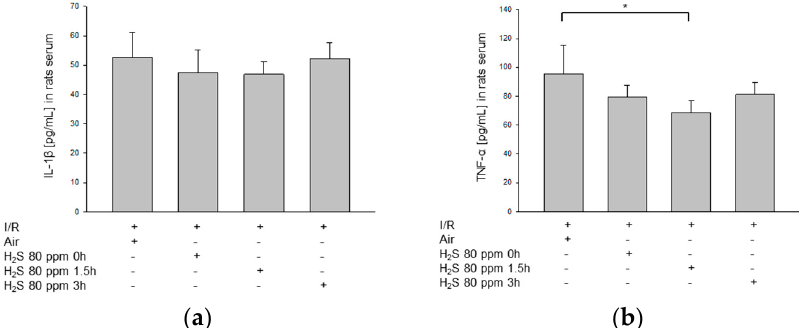
Figure 7. Effect of H 2 S inhalation on IL-1 β and TNF- α levels in peripheral blood samples. ( a ) Analysis of IL-1 β levels after IRI and subsequent H 2 S inhalation (80 ppm) (pg/mL). ( b ) Analysis